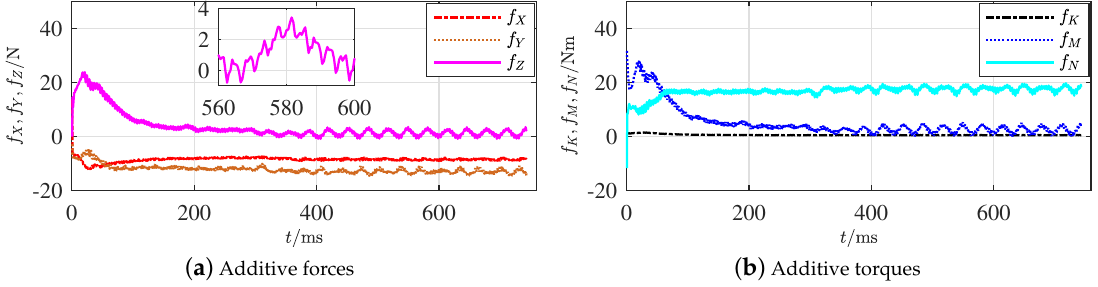
Figure 6. Additive forces and torques of rudder faults outside the